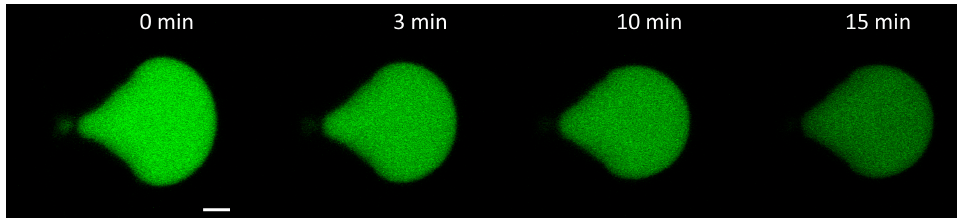
Figure 4. Confocal fluorescence images of calcein leakage from an exemplary POPC / POPG (9:1) GUV with azoALY added externally (50 µ M at time 0 min. A single GUV was held in one spatial location using a microfluidic platform; for details, see reference [39]. Scale bar: 5 µ m. After 15 min. of incubation with the peptides, the GUVs preserved their membrane structure (i.e., no visible defects), so we exclude the destruction of the membrane or micron-sized pore